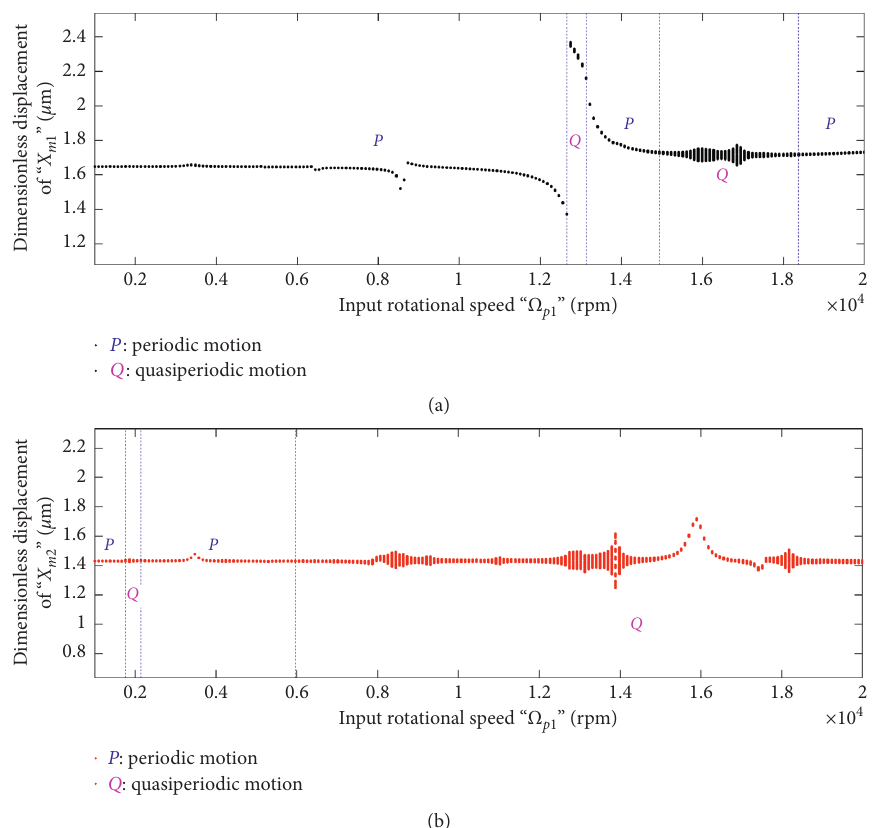
Figure 23: Forward bifurcation diagrams of system when K